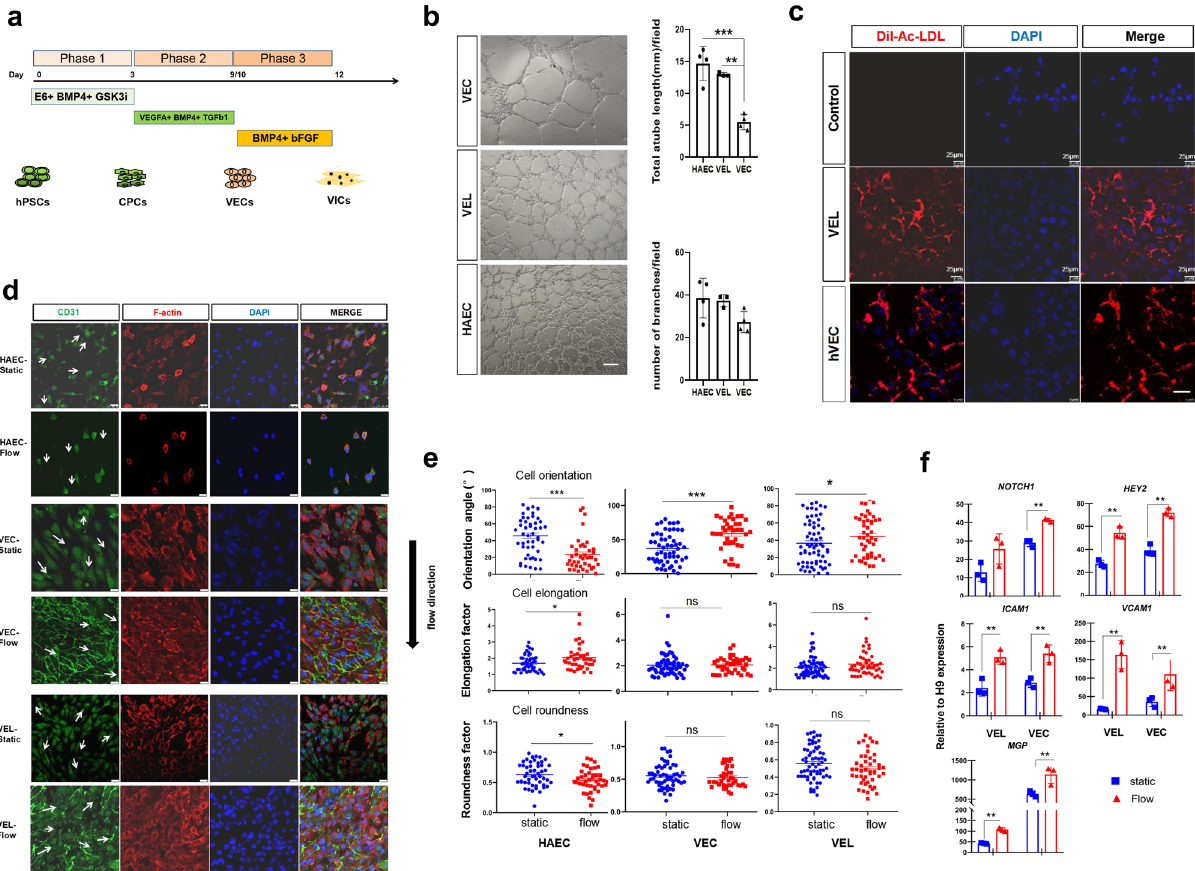
Fig. 6 Functional characterization of hPSC-derived VELs. a Cartoon depicting the protocol that is used to differentiate hPSC to VELs in 10 days. b Tube formation assay of day 7 hPSC-derived VELs, the primary VECs and HAEC. Left: representative images; right: quanti fi cation of capillary-like structures in terms of branches and tube length by ImageJ. Scale bar: 25 μ m. c Fluorescence signals showing that hPSC-derived VELs could uptake Ac-LDL, similar to primary VECs. d Confocal images showing the alignment of hPSC-derived VELs, the primary VECs from 16-year old and HAEC after exposed to fl uid fl ow for 48 hpf. Fluid fl ow direction is shown by the black arrow. White arrows show the direction of individual cells. Scale bar: 25 μ m. e Quanti fi cation of cell shape and orientation for primary VECs, VELs, and HAEC, under static and fl ow conditions ( d ). Cell shape and orientation were quanti fi ed by ImageJ. At least 50 cells were evaluated per condition across three independent replicates. Graph shows mean as horizontal bar. f The qRT-PCR analysis of indicated genes for VECs and VELs under static and fl ow conditions. All experiments were repeated three times. The paired t test in Graphpad software was used for the statistical analysis. Signi fi cant levels are: * p < 0.05; ** P < 0.01; *** P < 0.001. Shown are representative images in ( b – e